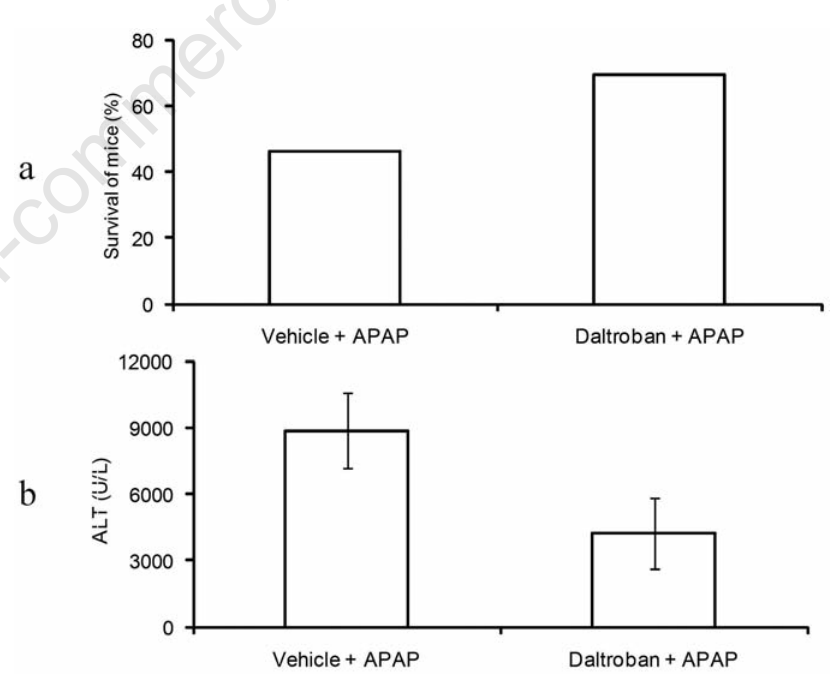
Figure 1. Effects of TXB and anti-TXB on survival and plasma ALT concentration in 2 2 mice with APAP-induced liver injury. (A) APAP (250 mg/kg) was given by oral gavage and survival was recorded 48 h later. TXB (2.0 mg/kg, i.p.) was given 30 min and anti-TXB 2 (40 m g/kg, i.p.) 3 h before APAP administration. Vehicle was given 30 min before APAP. N=13 mice per group.*P<0.05 in comparison to vehicle group. (B) To determine the plas- ma ALT concentration, mice were treated as in the previous experiment, except that mice